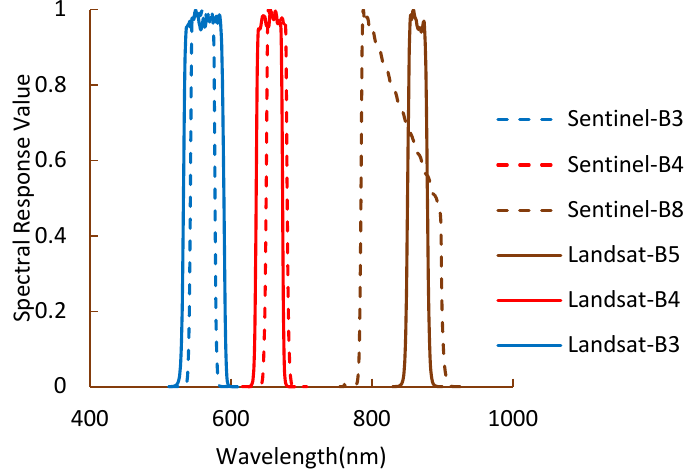
Figure 13. Spectral response function of Sentinel-2 MSI and Landsat-8 OLI.